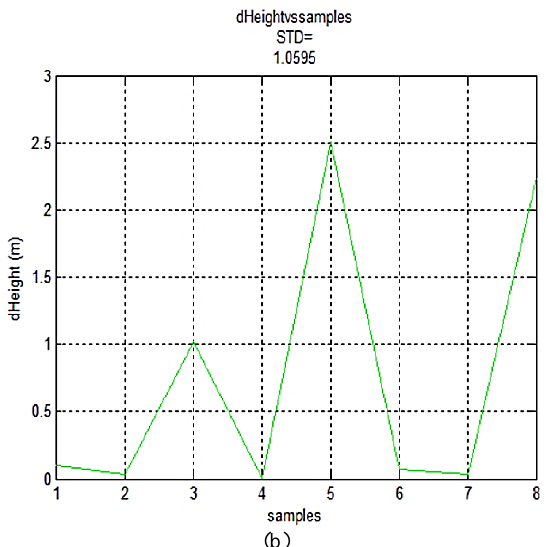
Figure 21. Coordinates differences: (a) Javad 2D Open Bucket test; (b) Javad Height Open Bucket